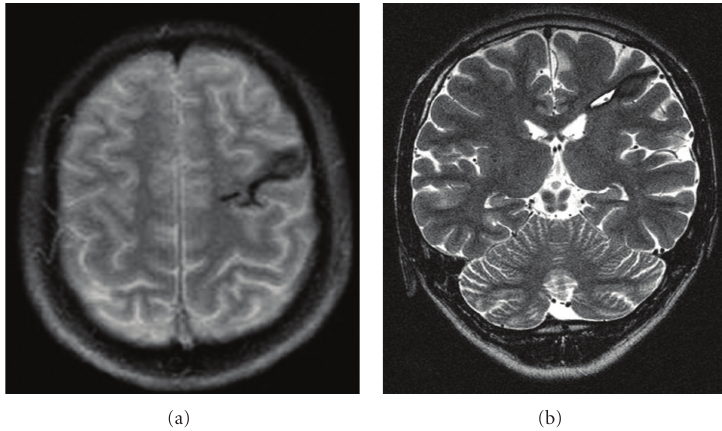
Figure 1: A 17-year-old boy was presented with seizures one month after a prior head injury. Axial T1-weighted image (a) and coronal T2-weighted image (b) showed the hemosiderin deposition and a small CSF-filled cavity of the left middle frontal gyrus.